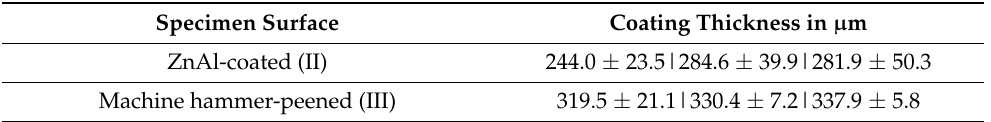
Table 2. Average coating thickness for three measurements each, at three locations in gauge length center: ZnAl-coated (II) and machine hammer-peened (III) Figure 9. Surface profiles of coating systems: ( a ) ZnAl-coated (II) specimen, ( b ) machine hammer- peened (III) specimen.